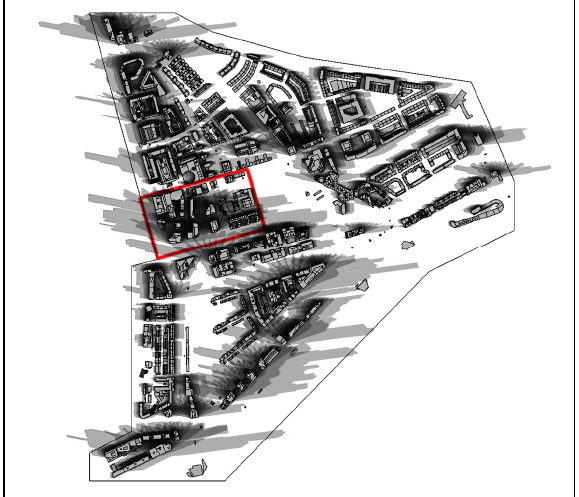
Figure 8. Shadow pattern in Rotterdam Stadsdreihoek – case of irregular height structure. Concentration of tall buildings marked in red (cityGML – LOD2), by: